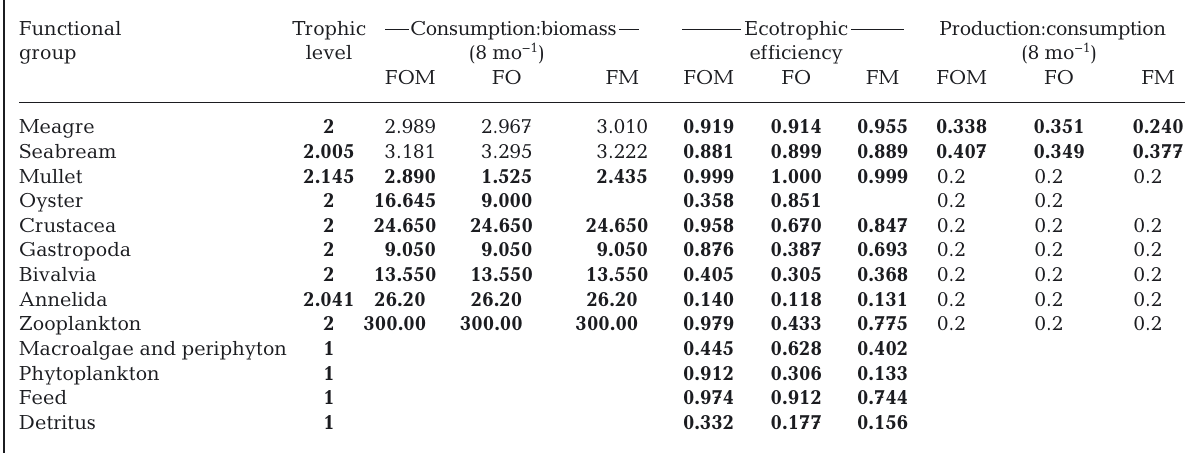
Table 5. Basic estimates of integrated multi-trophic aquaculture (IMTA) Ecopath models, in bold . Non-bold numbers are input values. FOM: fish, oysters and macroalgae; FO: fish and oysters; FM: fish and